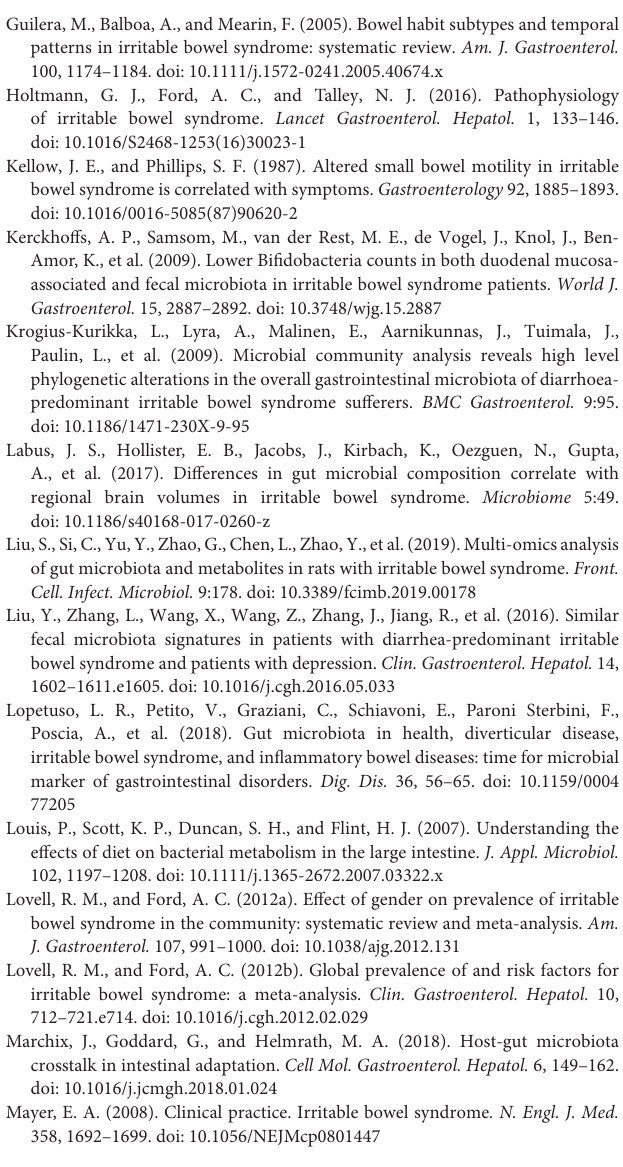
Table S1 | Correlation of fecal metabolites with clinical traits of IBS. Table S2 | Correlation of fecal microbes with clinical traits of IBS. Table S3 | Major differentially abundant fecal metabolites in IBS patients and healthy